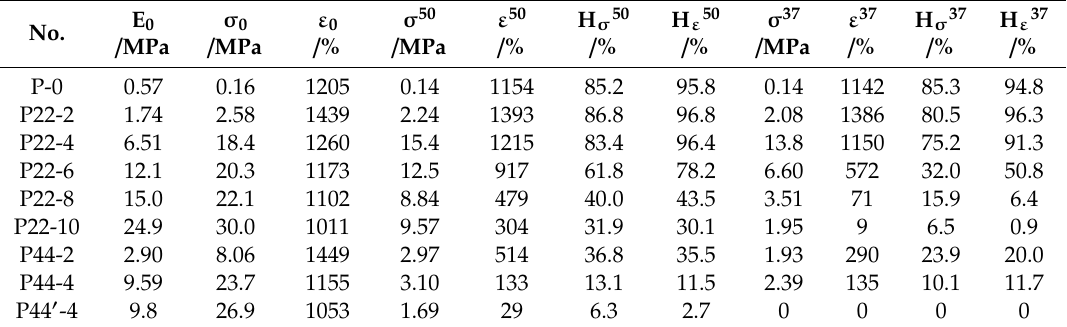
Table 2. Mechanical properties of the WPUR film before and after healing for 24